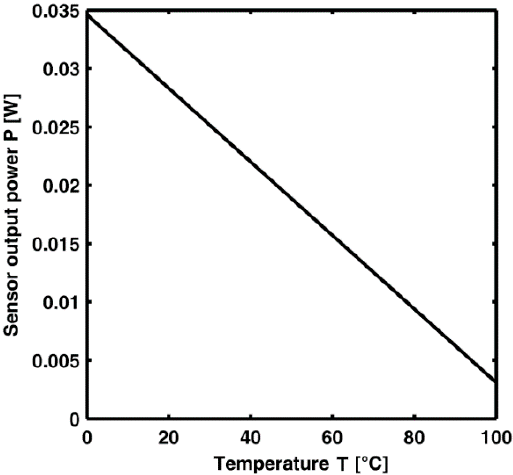
Figure 10. Sensor output versus the temperature for the pump power P p = 1.1